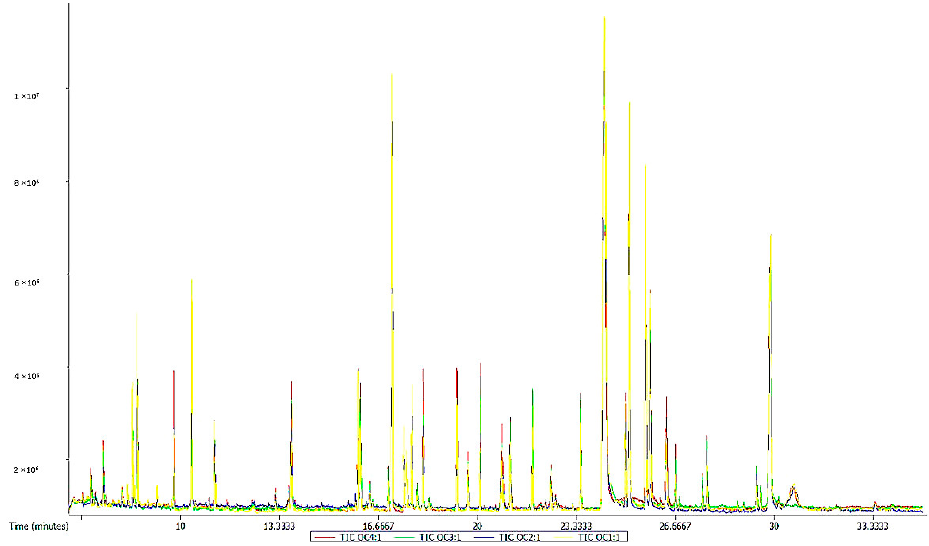
Figure 1. TIC overlay of all quality control (QC) samples.